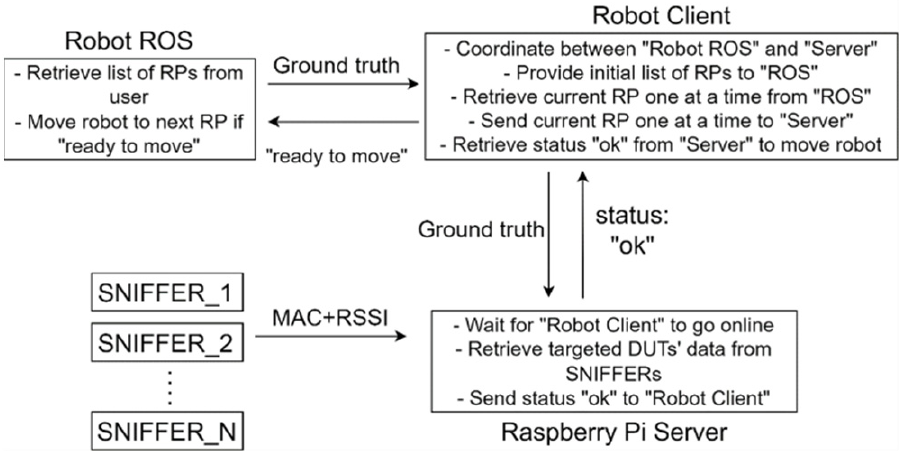
Figure 9. Logical flow for coordination between the robot and the server for automated collection of training data.